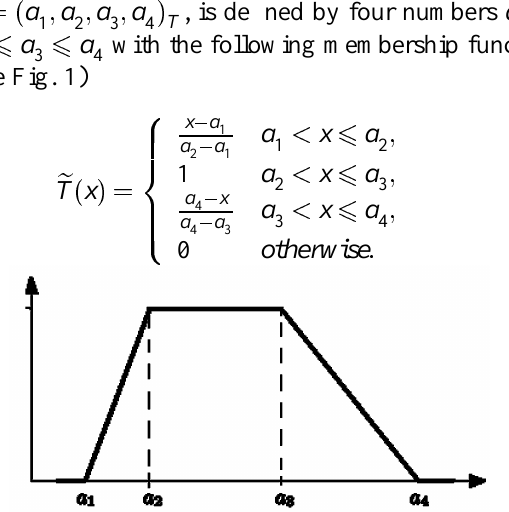
Fig. 1. Trapezoidal fuzzy